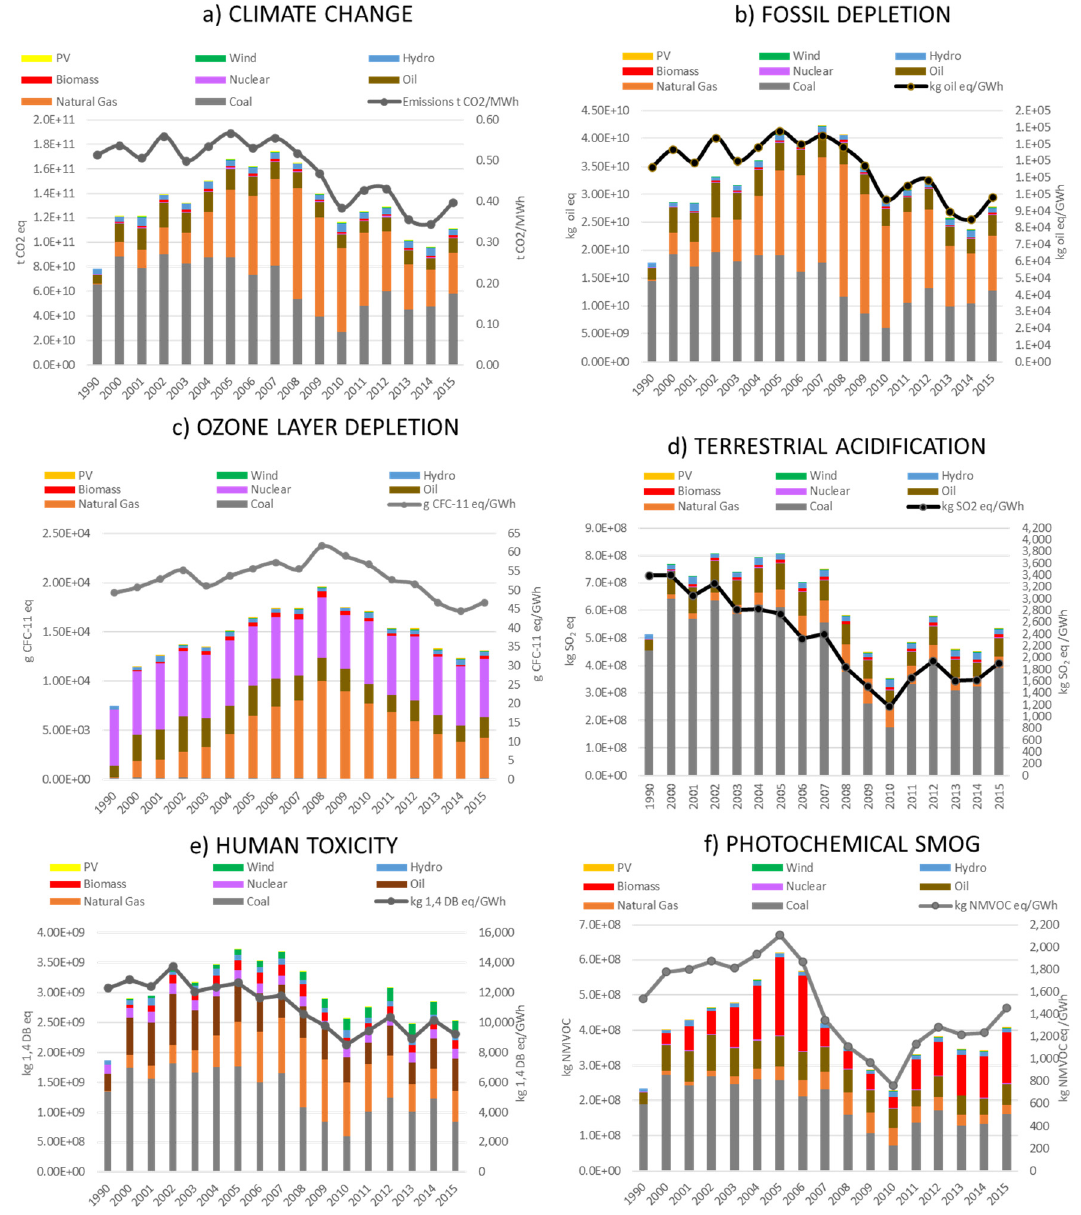
Figure 8. Historic environmental performance of Spain’s electricity system (1990–2015): ( a ) climate change, ( b ) fossil depletion, ( c ) ozone layer depletion, ( d ) terrestrial acidification, ( e ) human toxicity, ( f ) photochemical smog.In the first stage of the ST scenario (2030), the results show a notable reduction (44%) in the emissions per unit of power, due to a decline in the contribution of coal, the complete elimination of oil and the increasing weight of renewables (mainly PV). In the second stage of the ST scenario (2050), the higher impact per unit of power compared with 2030 is associated to the prevalence of natural gas in the power mix and the not so decisive upsurge in the penetration of renewables.